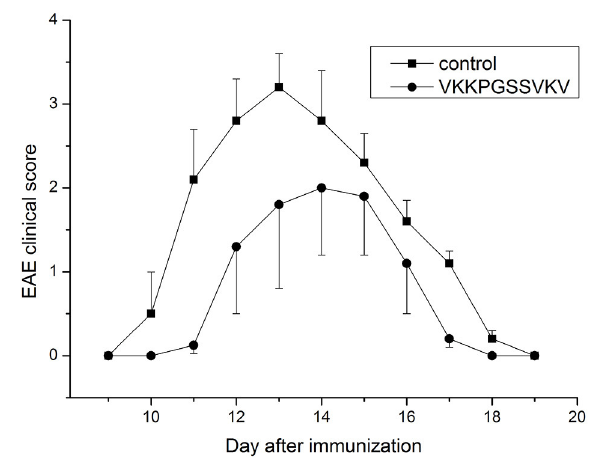
FIGURE 1 | The expression of clinical signs of EAE in adult rats after immunocortin (VKKPGSSVKV) treatment. EAE clinical score was determined as described in Materials and methods. Rats were treated daily with immunocortin 400 µ g/kg or normal saline (control). Each value shown is the mean ± SEM ( n = 10) of clinical disease, which was scored from day 9 post-immunization (p.i.) until day 19 p.i. ( p < 0.01, by Friedman’s ANOVA). Calculated SEM are presented on the graph as error bars in the direction of plus or minus to avoid